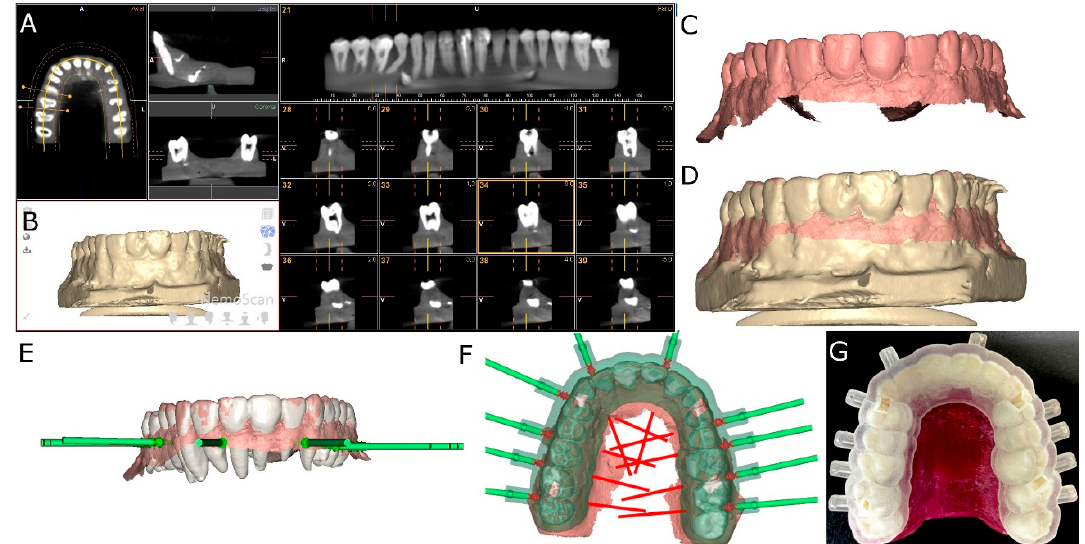
Figure 1. ( A , B ) DICOM files from the CBCT scan, ( B ) CBCT scan rendering, ( C ) STL digital file from the digital impression, ( D ) alignment procedure between STL and CBCT scan digital files, ( E ) orthodontic micro-screws planning position, ( F ), surgical template design and ( G ) manufacturing.